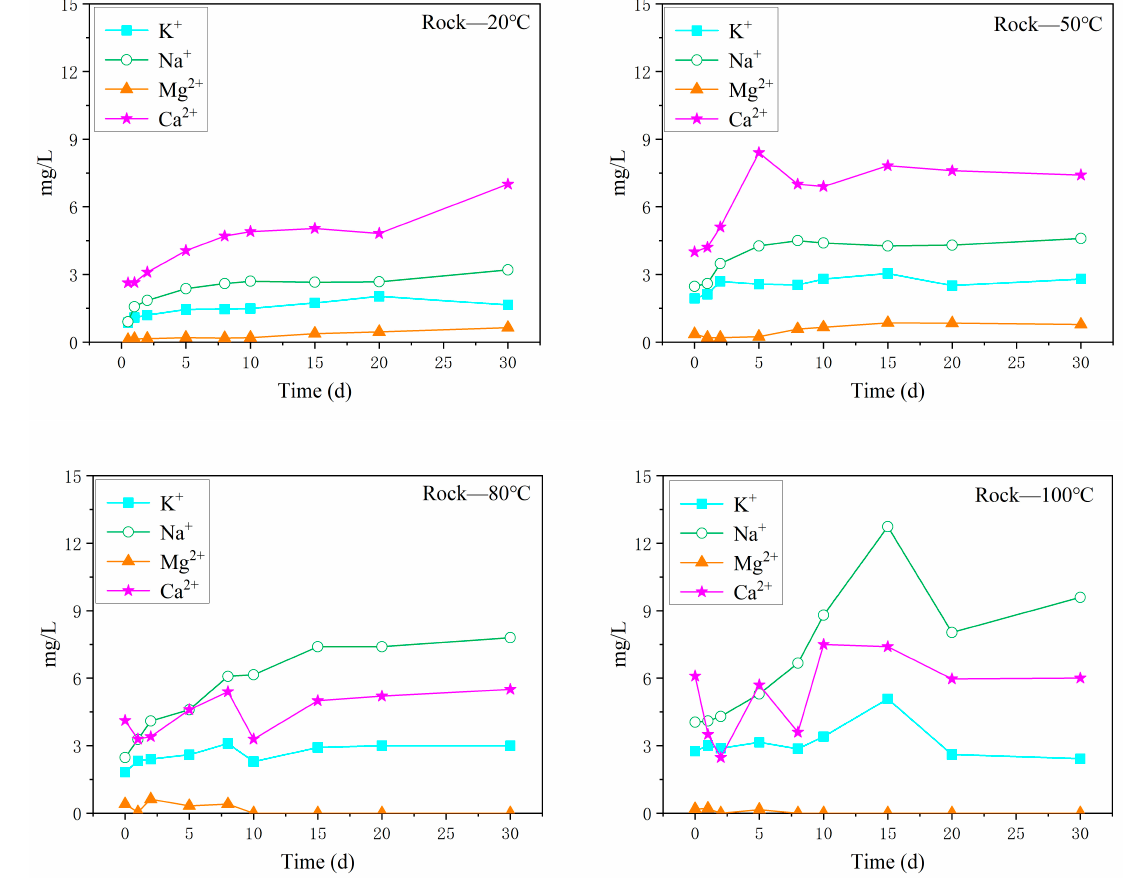
Figure 6. Variation in the content of the main cations in the oil shale–surrounding rock aqueous solution under different temperature reaction conditions.